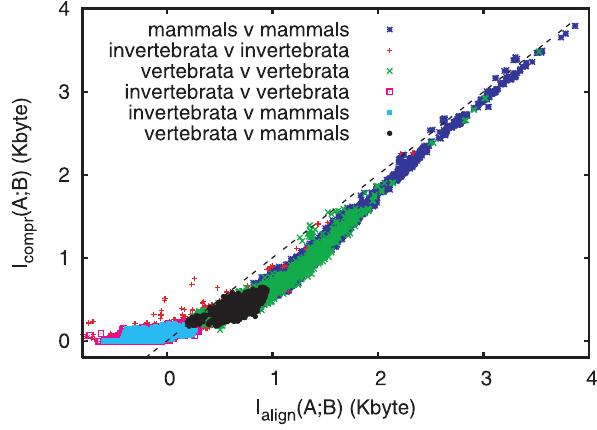
Figure 2. Scatter plot of MI estimates for complete mitochon- drial DNA between pairs of species: I compr using XM [ 19 ] vs. I align using MAVID [ 27 ] followed by compression with lpaq1. Note that the two estimates generally agree and fall on the diagonal, while in some cases one method does better than the other as explained in the text. Here and in Figure 3 ‘‘vertebrata’’ means non-mammalian vertebrata. This plot contains roughly 36,000 pairs, about 16,000 of which contain two mammals, the other 20,000 covering equally the other combinations. I align is the average between the values obtained from T B D A and T A D B